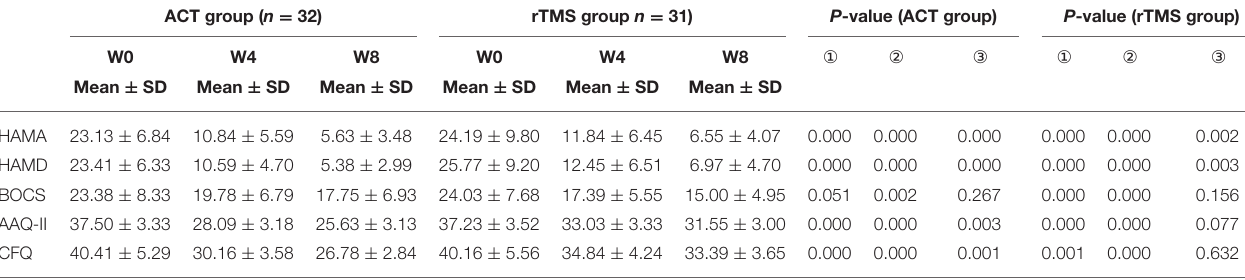
TABLE 5 | Comparison of anxiety and depression, OCS, and psychological flexibility in the two group. ACT group ( n =